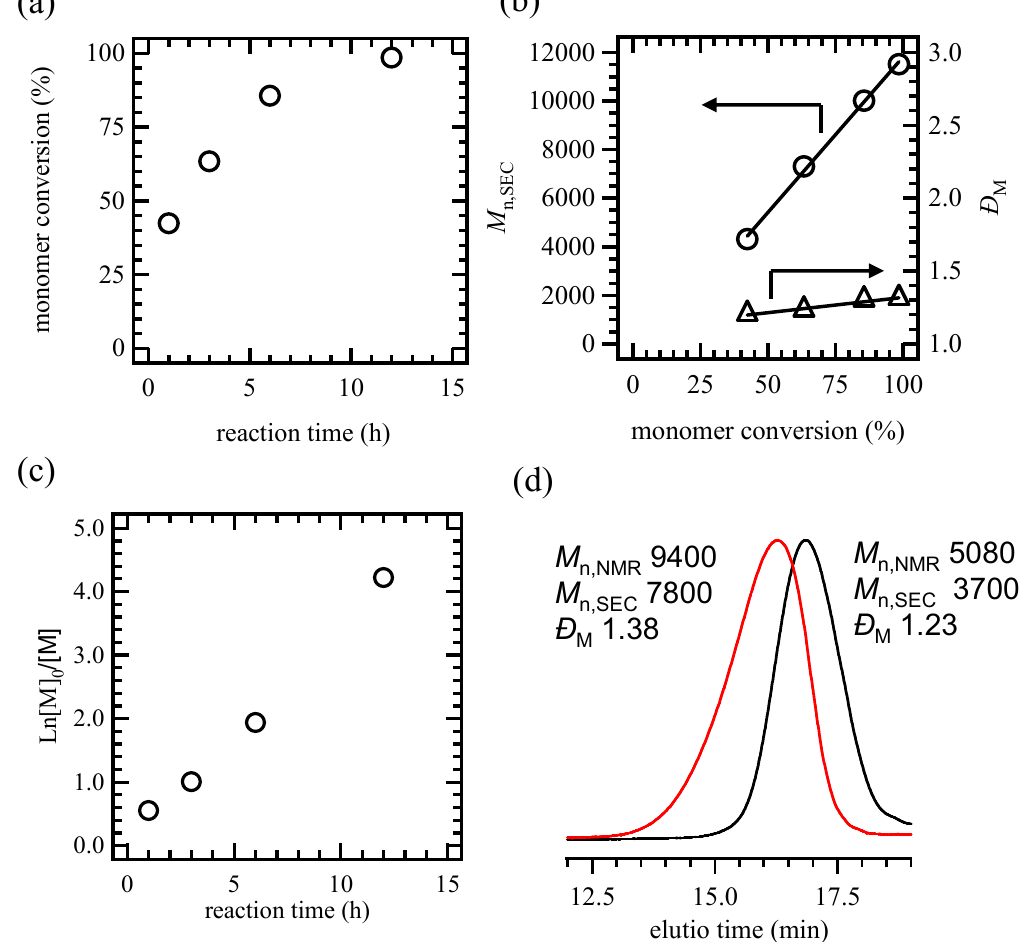
Figure 7. ( a ) Time-conversion plot in the SCTP of M2 ([ M2 ] 0 /[ FI−CH 2 OH ] 0 /[Pd 2 (dba) 3 •CHCl 3 ]/[ t -Bu 3 P]/[K 3 PO 4 ] = 15:1:0.3:2.2:1.5; solvent, THF/water (10:1, v / v ); temp., 30 °C). ( b ) Dependence of M n,SEC and Ð M on the monomer conversion. ( c ) Kinetic plots for SCTP. ( d ) SEC traces of 2,7-PCz (black line) and 2,7-PCz- b -PF obtained after the second polymerization (red line).